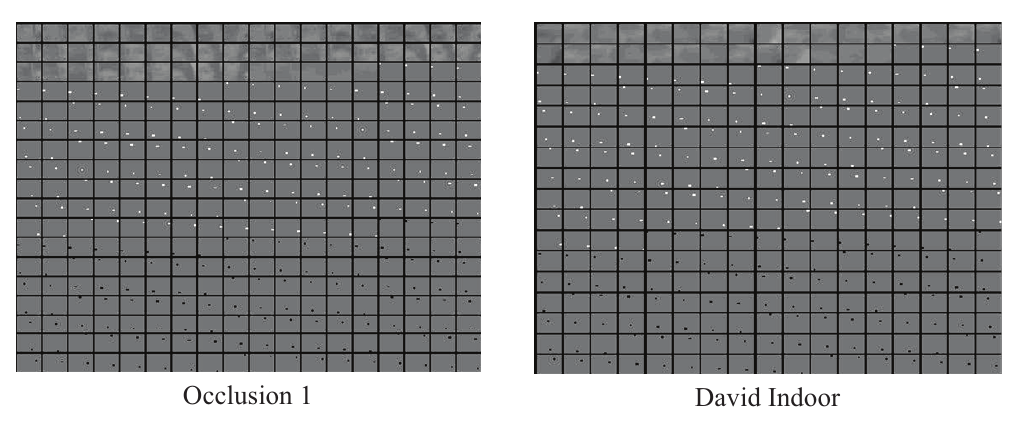
Table 2. Running time, average center error and ORE of different normalized patch sizes for Car 11